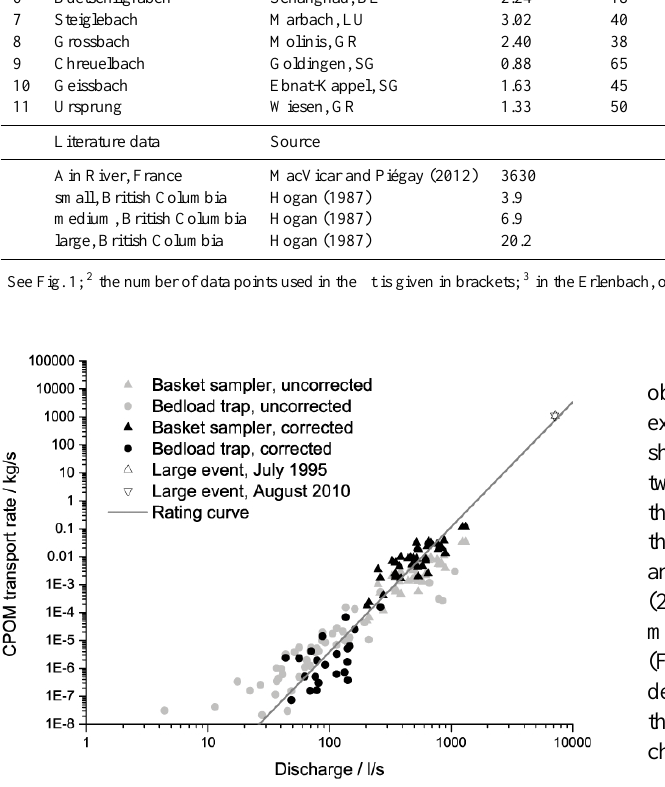
Figure 5. CPOM transport rates as a functions of discharge. Both the untreated data (light grey) and the values corrected for transport rates of all particles heavier than 0.1g (black) are shown. The rating curve is of the form Q CPOM = aQ b , with a = 4 . 42 × 10 − 15 and b = 4 . 47 ± 0 . 21, with an R value of 0.94. The two data points from the large events (open triangles) plot nearly at the same location. They were not used in the regression to obtain the rating